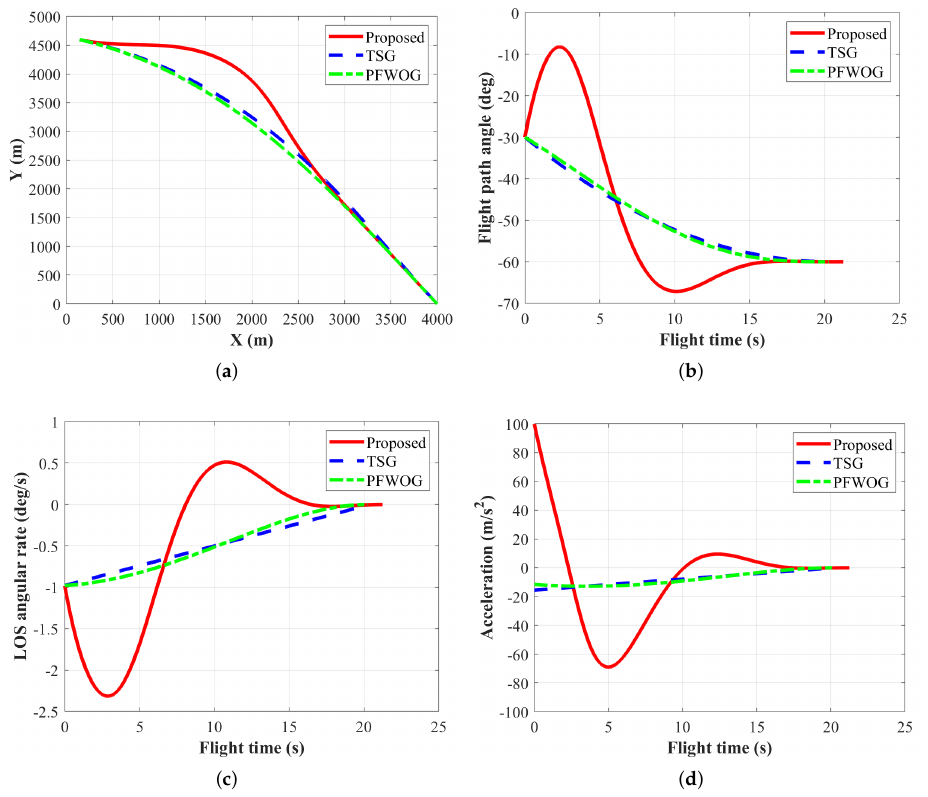
Figure 3. Comparative simulation results under different guidance laws: ( a ) trajectory profiles; ( b ) flight path angle; ( c ) LOS angular rate; ( d ) acceleration